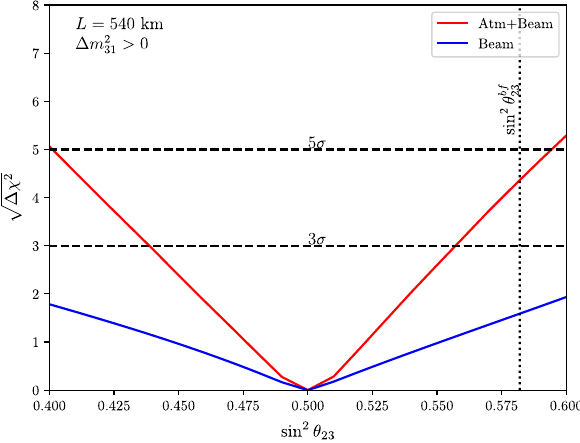
Fig. 6 Significance withwhich the wrong octant would be disfavoured as a function of the actual value of θ 23 with beam-only information (blue lines) and including also the atmospheric dataset (red lines) for the baseline to Garpenberg ( L = 540 km) and normal mass ordering. Therunningtimesplittinghasbeenassumedtobe t ν = t ¯ ν = 5years.The results for the Zinkgruvan site ( L = 360 km) and for inverted ordering are very similar. The vertical line represents the present best fit for θ 23 from